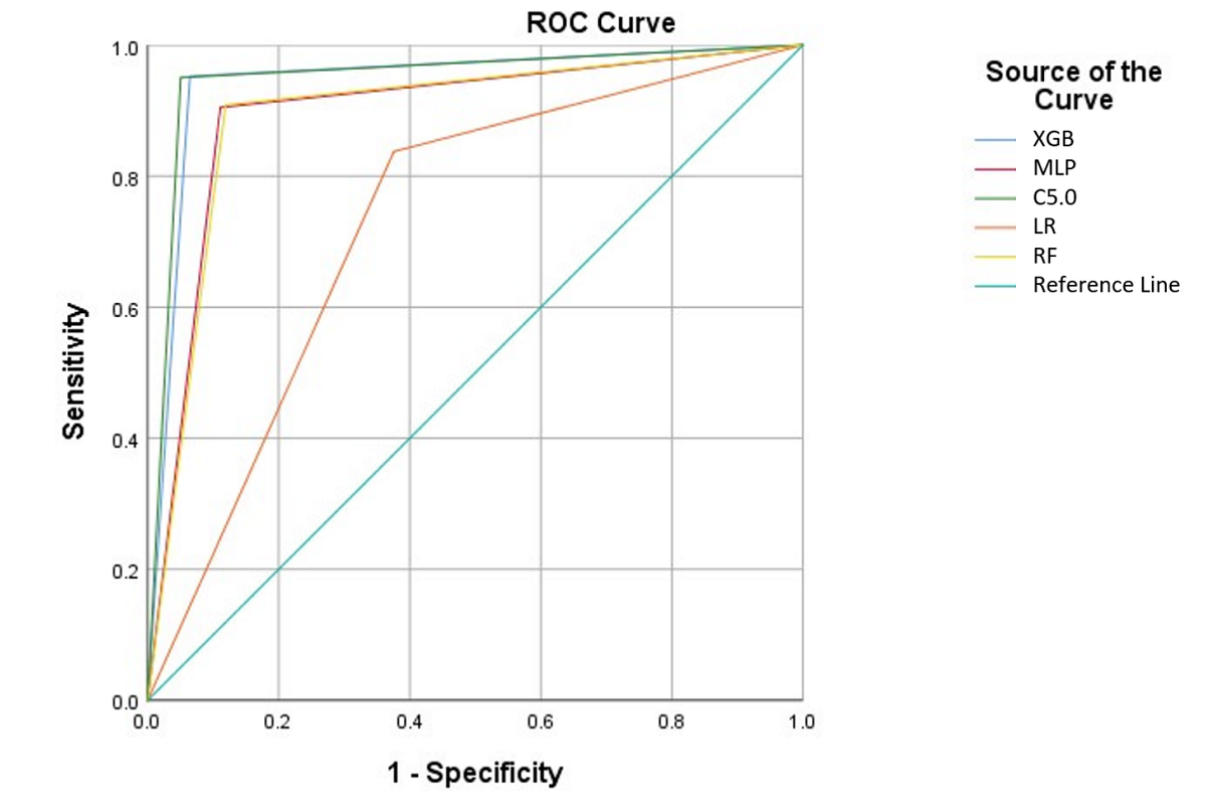
Figure 1. Mean receiver operating characteristic curve for the 5 machine learning algorithms. C5: C5 decision tree; LR: logistic regression; MLP: